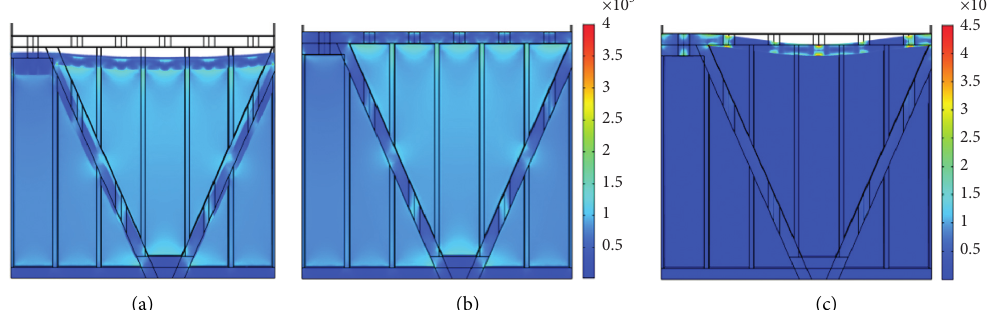
Figure 16: The steady-state stress distribution after being subjected to the same normal pressure. The deformation is enlarged 5000, 50000, and 50000 times from (a) to (c), respectively.